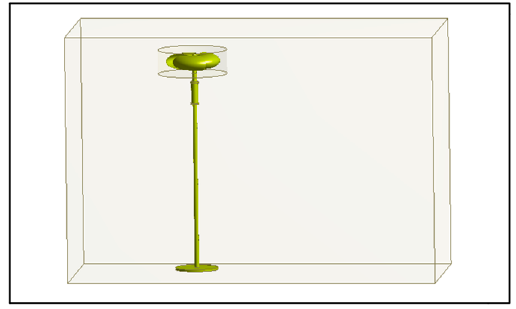
Figure 1. ( a ) The Nautilus isometric spiral wind turbine model; ( b ) The wind blade model.